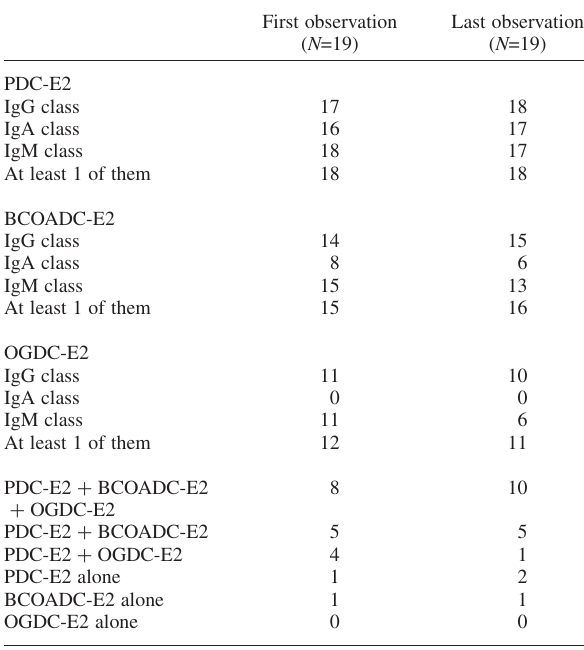
TABLE II Immunoblotting to recombinant mitochondrial proteins